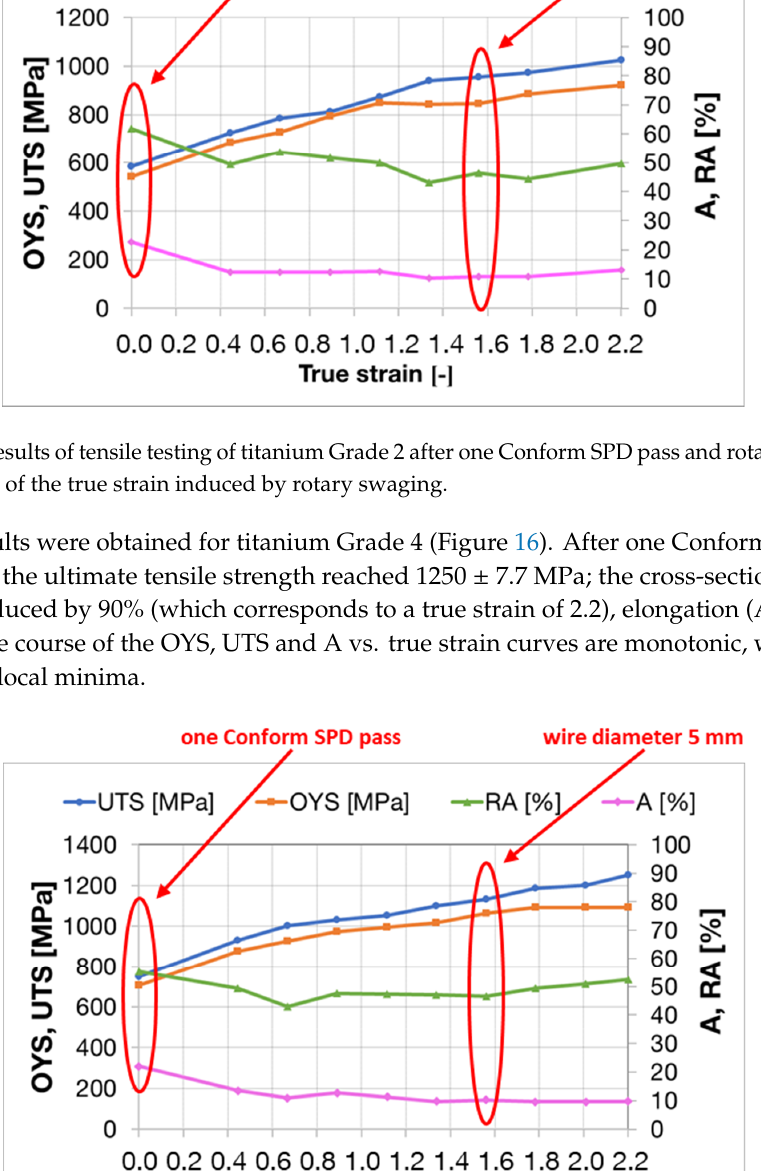
Figure 17. Results of tensile testing for titanium Grade 2 after rotary swaging as a function of the true strain induced by rotary swaging.